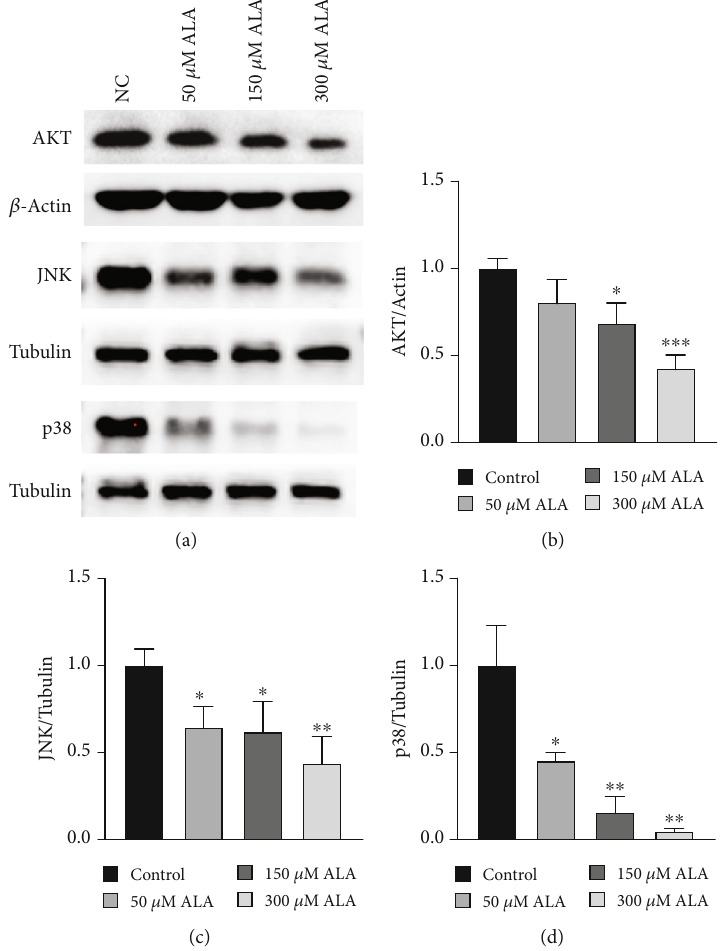
Figure 3: ALA suppressed the PI3K/AKT, JNK, and p38 MAPK signaling pathways in NCM460 cells. (a) Western blot showed that the activation of AKT, JNK, and p38 was suppressed by treatment with the ALA in NCM460 cells. (b) Quanti fi ed histograms of AKT protein levels normalized by actin. (c) Quanti fi ed histograms of JNK protein levels normalized by tubulin. (d) Quanti fi ed histograms of p38 protein levels normalized by tubulin. Data represent mean ± SD from at least three independent experiments. ∗ P < 0 : 05 , ∗∗ P < 0 : 01 , and ∗∗∗ P < 0 : 001 compared to